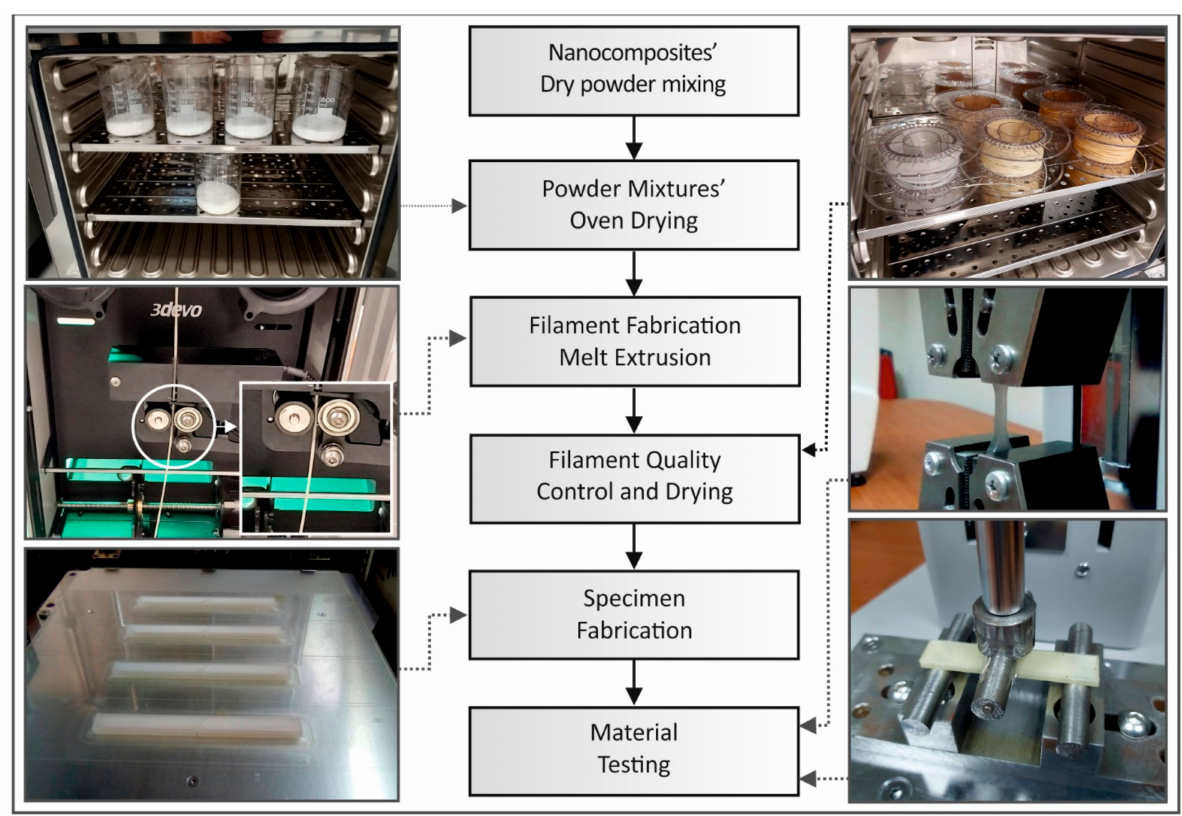
Figure 1. Methodology flow chart followed in this study, in a combination with pictures captured during test